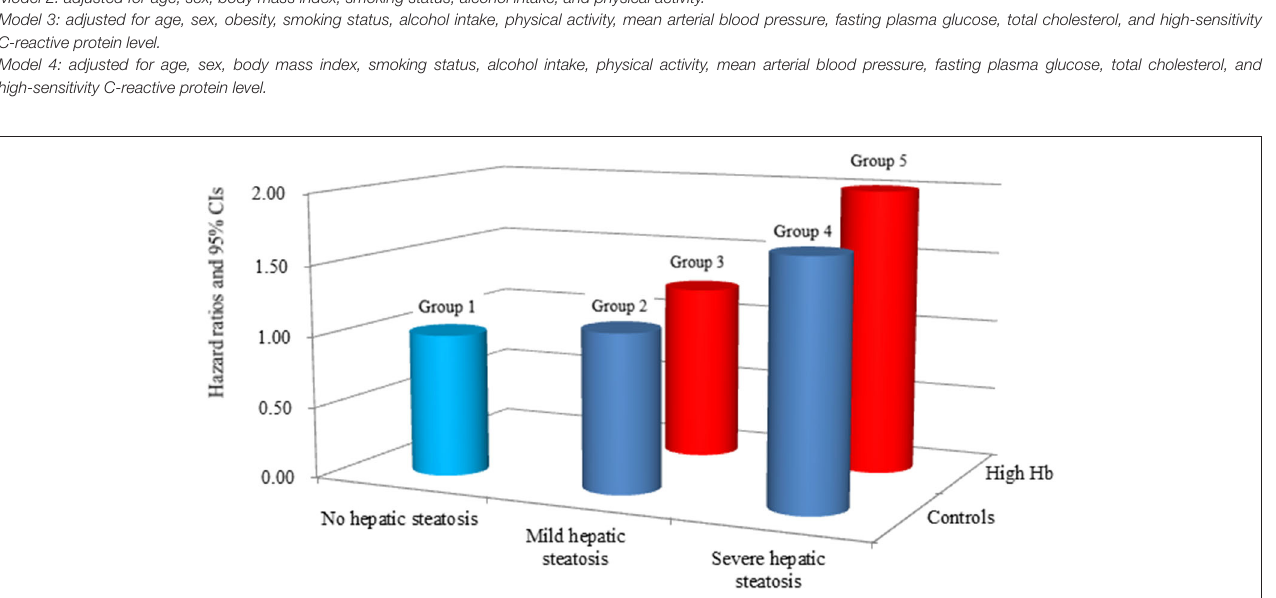
consideration. Hb is an iron-containing protein, and